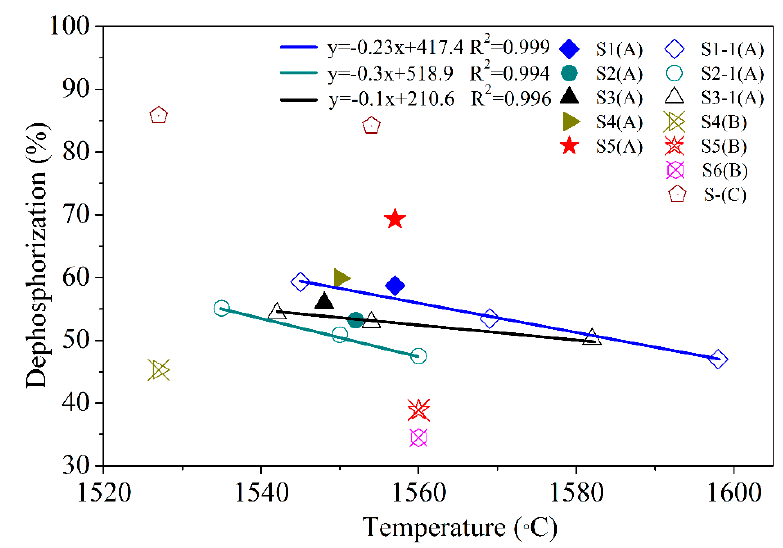
Figure 2. Relationship between the dephosphorization rate and temperature. S1 (A) is LF1 + CaO + Al 2 O 3 , S4 (B) is LF4 + Al 2 O 3 . S1–1 (A), S2–1 (A), and S3–1 (A) are tests for 200 g of metal.